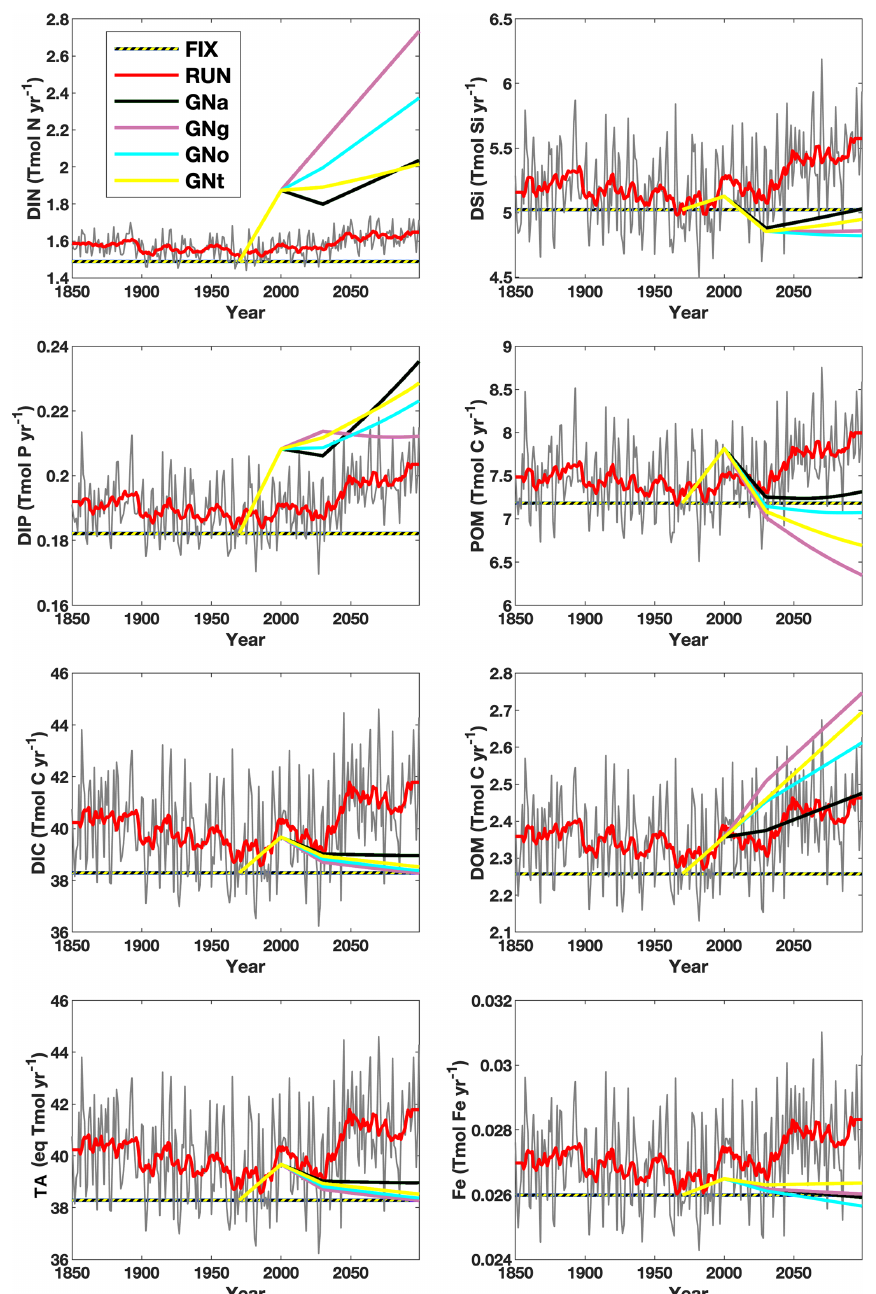
Figure 2. Time series of global riverine fluxes of nutrients and carbon to the ocean according to the configuration of six model experiments (FIX, RUN, GNa, GNg, GNo, and GNt). The thin grey and thick red curves are the annual and 11-year running mean fluxes, respectively, in RUN. DIN: dissolved inorganic nitrogen; DIP: dissolved inorganic phosphorus; DIC: dissolved inorganic carbon; TA: alkalinity; DSi: dissolved silicon; POM: particulate organic matter; DOM: dissolved organic matter; Fe: dissolved iron.